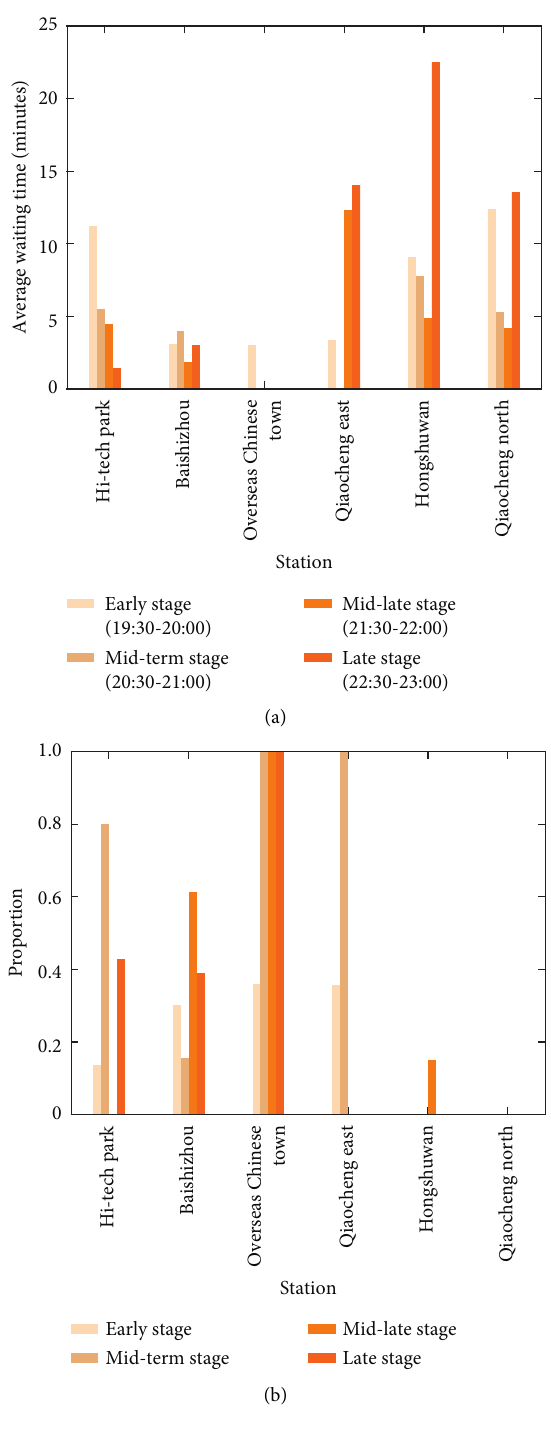
Figure 11: (a) The average waiting time of passengers at six al- ternative stations. (b) The proportion of pedestrian passengers to the total passengers at each alternative